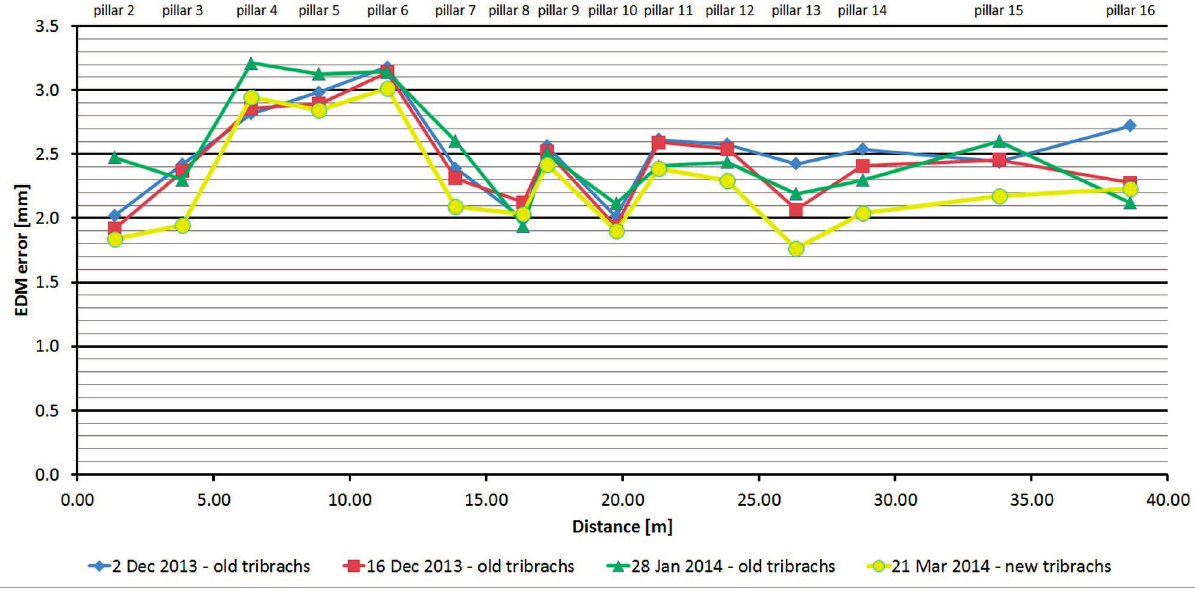
Figure 14. Topcon GPT-7501–Absolute errors in four